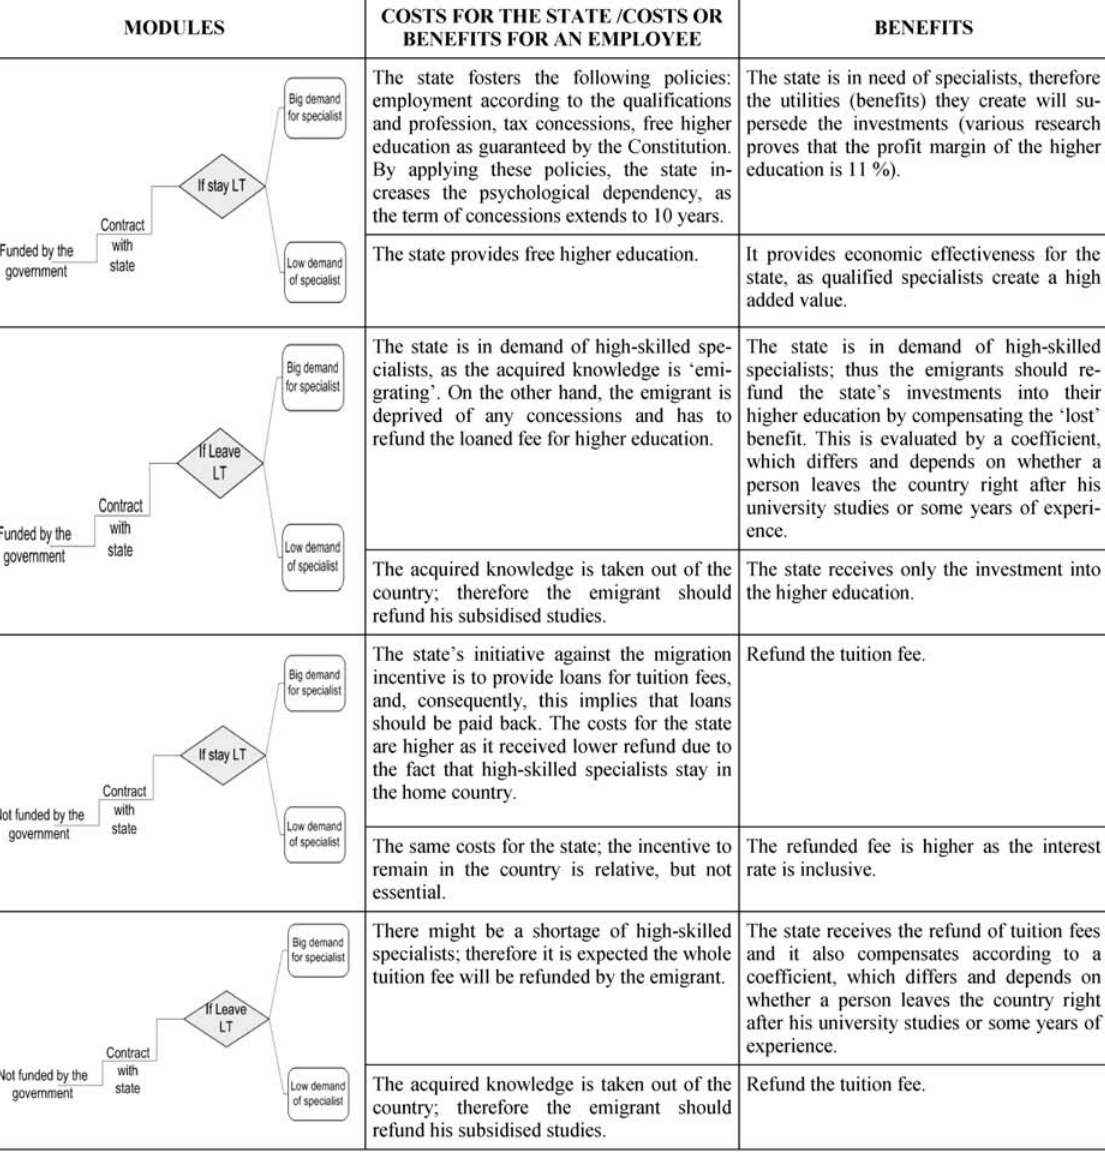
Fig 2. The Models’ cost-and-benefit analysis for the state and employees